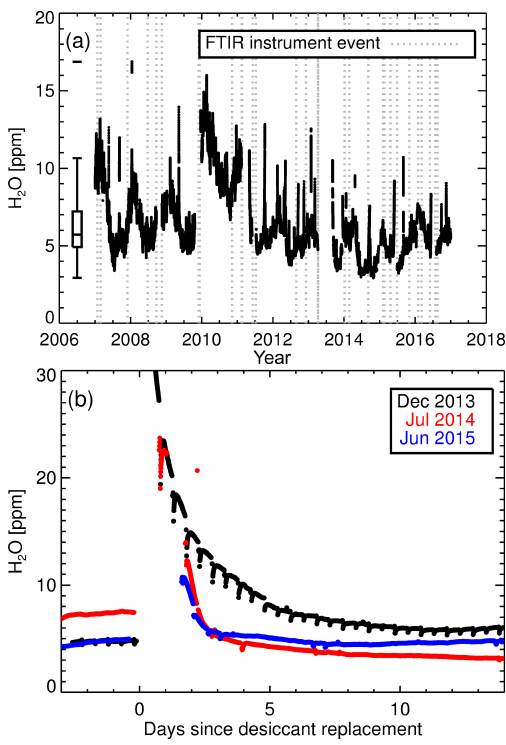
Figure E1. (a) Retrieved H 2 O during air-sample measurements. The near-vertical spikes in H 2 O relate to desiccant cartridge replen- ishment and subsequent drying out of the cell. All measurements with H 2 O >20ppm are filtered out prior to calibration and analy- sis. The elevated level of H 2 O (approx. 2ppm) over 2010–2011 is unexplained. (b) Three examples of cell H 2 O after desiccant car- tridge replacement. The twice daily small reductions in H 2 O in the Dec2013 data are due to daily calibration and target cylinder mea-